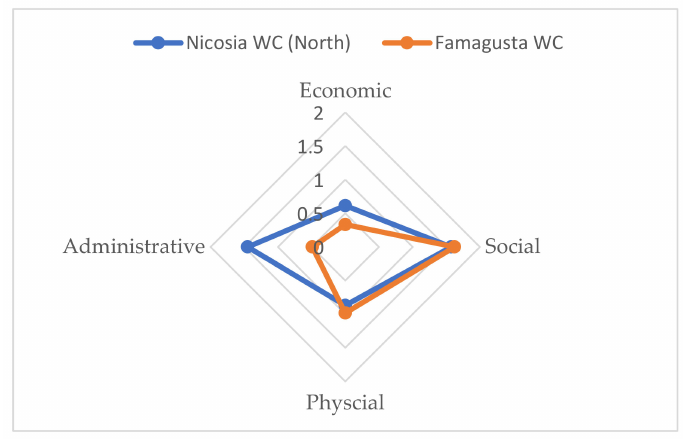
Figure 8. Comparison of Main Criteria Results for the case